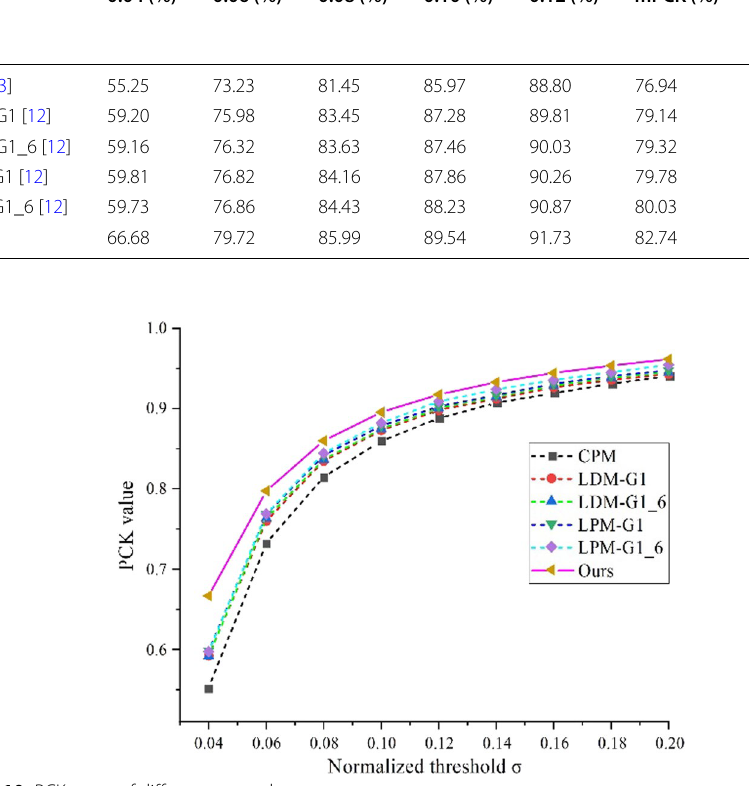
Table 1 Comparison of the improved NSRM model with other models on the test set σ PCK 0.04 (%)